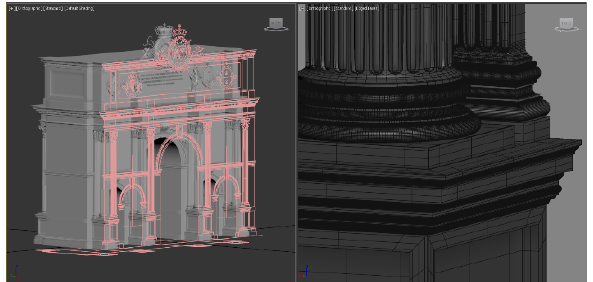
Figure 8. Making of the 3D model of the triumphal arch.